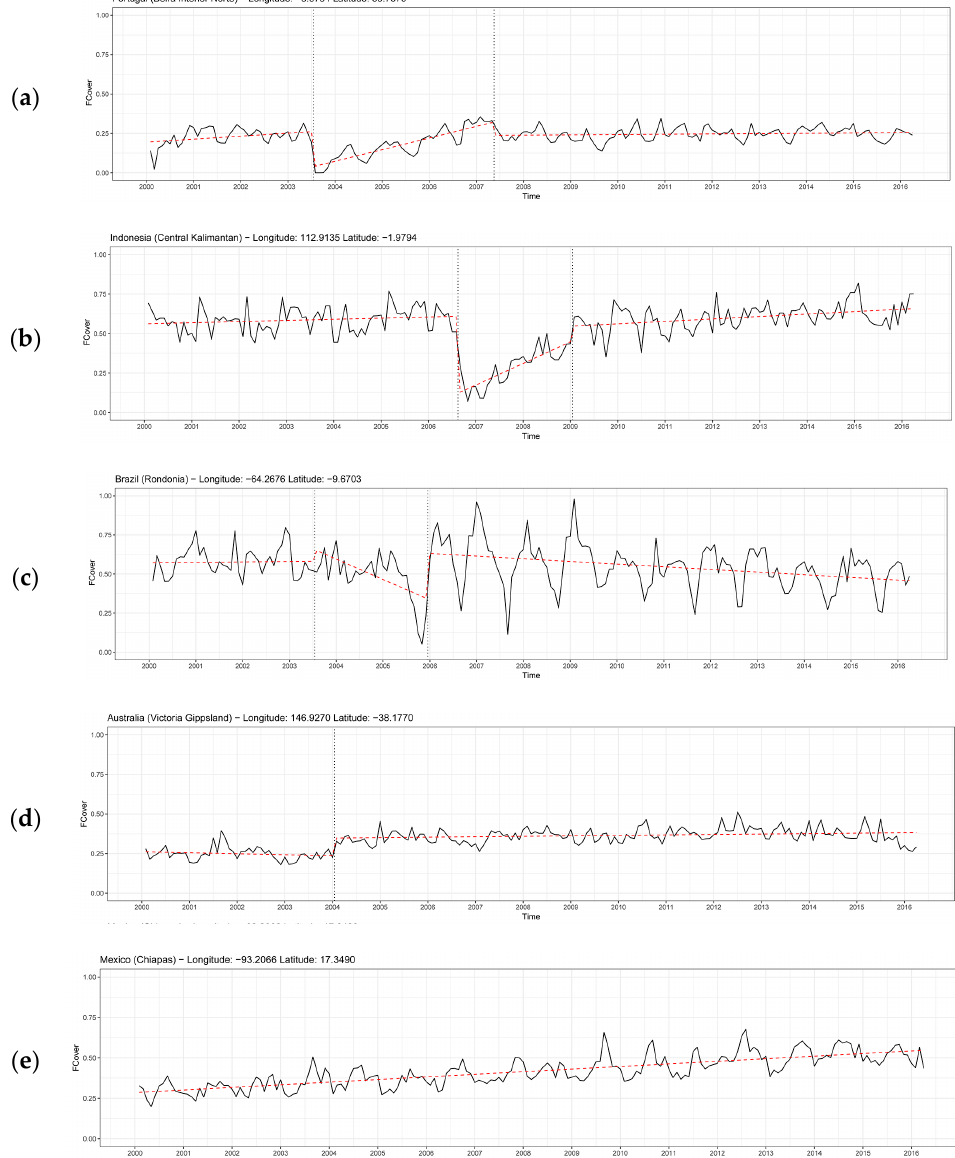
Figure 5. Temporal profile (black line), temporal trend (dashed red line), and strong change in temporal profile (i.e., the break represents the highest change in pixel temporal profile; dotted vertical black line) of the selected case study sites: ( a ) Portugal, ( b ) Indonesia, ( c ) Brazil, ( d ) Australia, ( e ) Mexico.